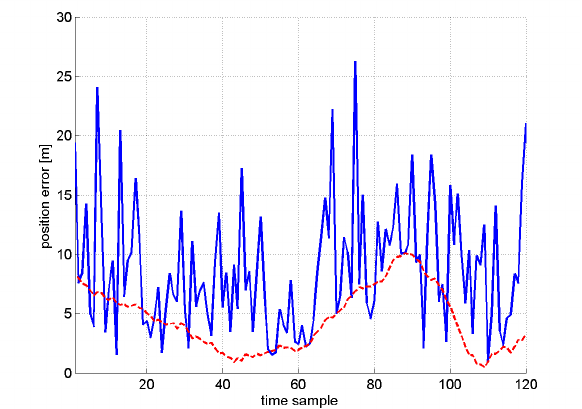
Figure 5: Positioning error: maximum likelihood (blue line) and Kalman (red dashed line)